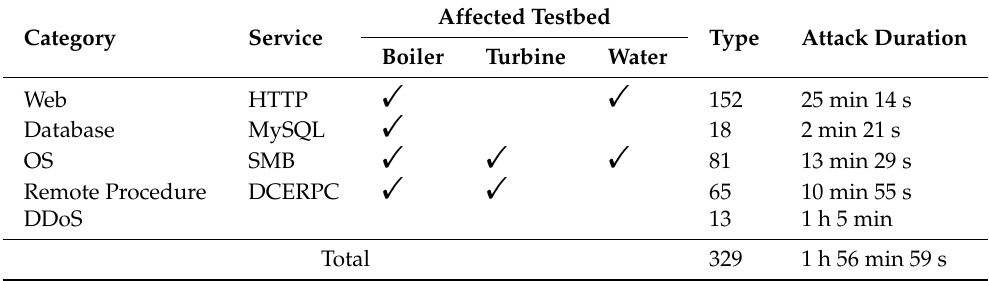
Table 3. Summary of attacks in scenario.